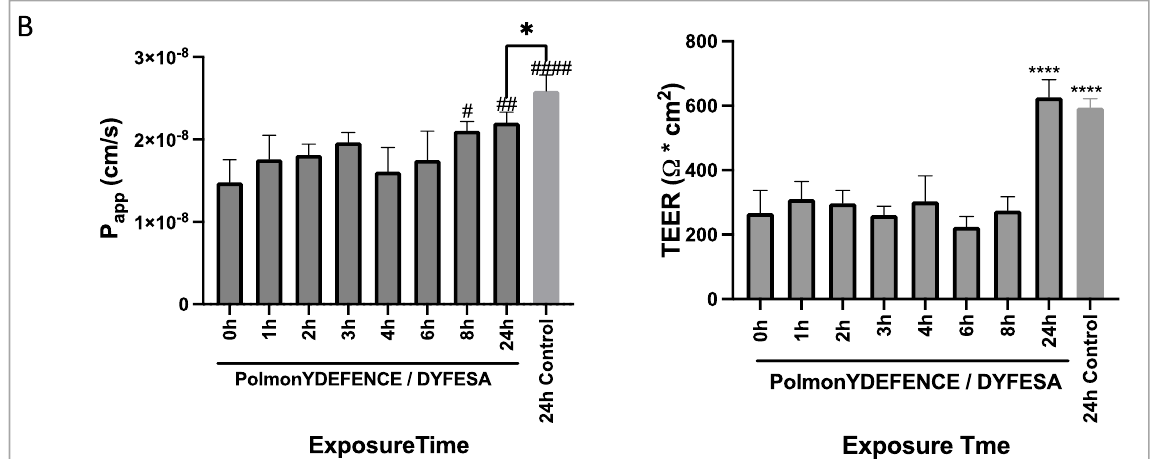
Figure 2. The measure of membrane integrity and permeability to test tight junction formation between cells +/ − urban dust. ( A ) Permeability coefficient and TEER measurements for epithelial electrical resistance in response to varying concentrations of urban dust ( B ) Permeability coefficient and TEER measurements for epithelial electrical resistance of the epithelium exposed to PolmonYDEFENCE/DYFESA over a 24 h time course. Statistical significance was calculated using one – w ay ANOVA with Dunnett’s multiple comparisons test ( ns = no statistically significant change, # p < 0.033; ## p < 0.0021; #### p < 0.0001, **** p < 0.0001) and student t -test (* p < 0.05).